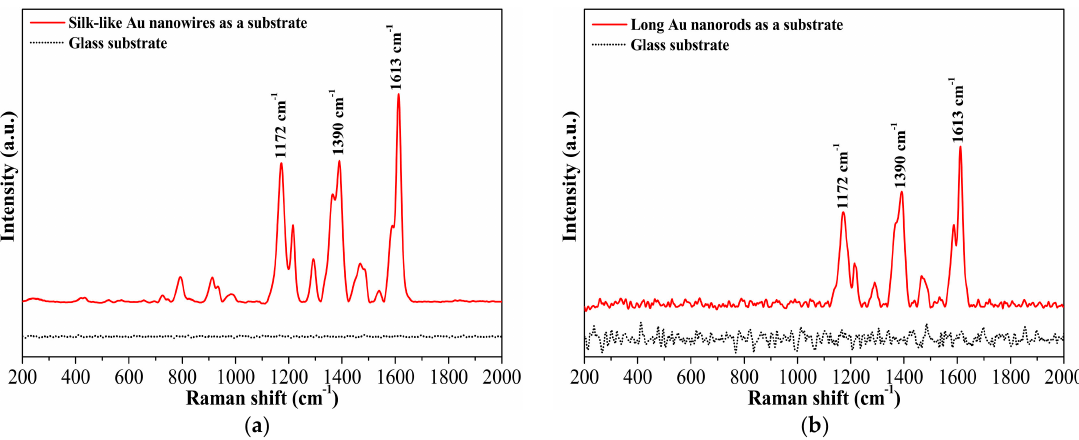
Figure 6. ( a ) SERS spectra of malachite green using silk-like ultralong Au nanowires as a solid substrate; ( b ) SERS spectra of malachite green using long Au nanorods as a solid substrate.